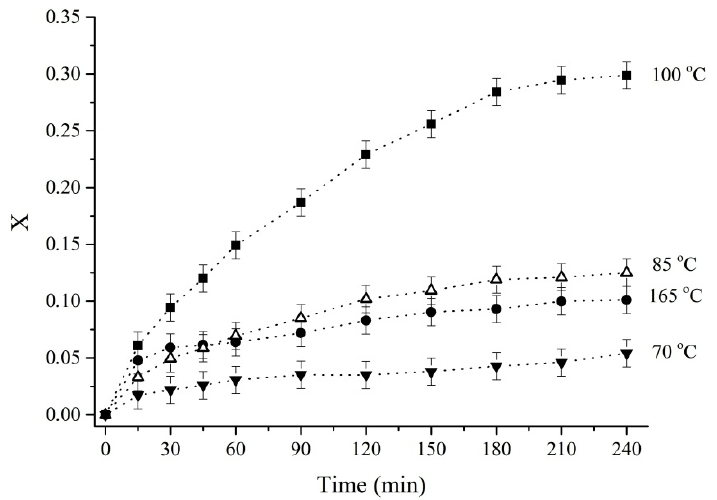
Figure 2. The kinetics of leaching of rutile during processing in H 2 SO 4 (85 wt%) at a mass ratio of Ti/F = 1/1 at temperatures: 70, 85, 100 and 165 °C.